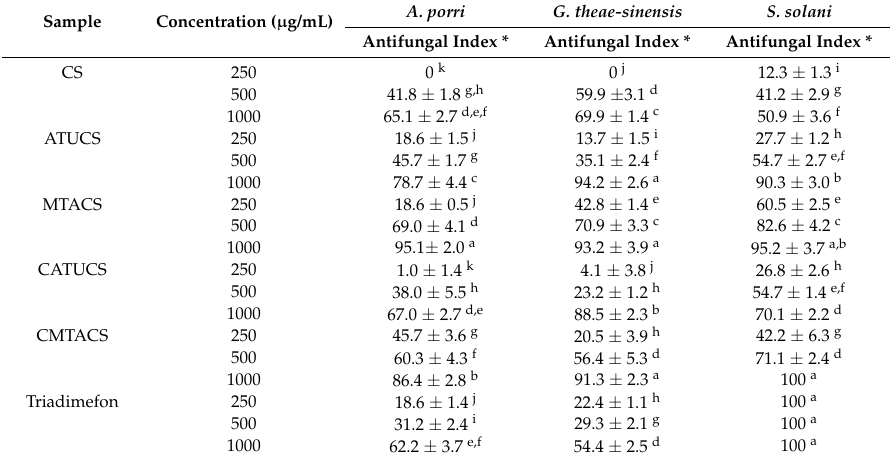
Table 2. Antifungal activity of chitosan (CS), acetyl thiourea chitosan (ATUCS), 3-methyl-1,2,4-triazolyl chitosan (MTACS), chloracetyl thiourea chitosan (CATUCS), and 3-chloromethyl-1,2,4-triazolyl chitosan (CMTACS) derivative against A. porri , G. theae-sinensis , and S. solani